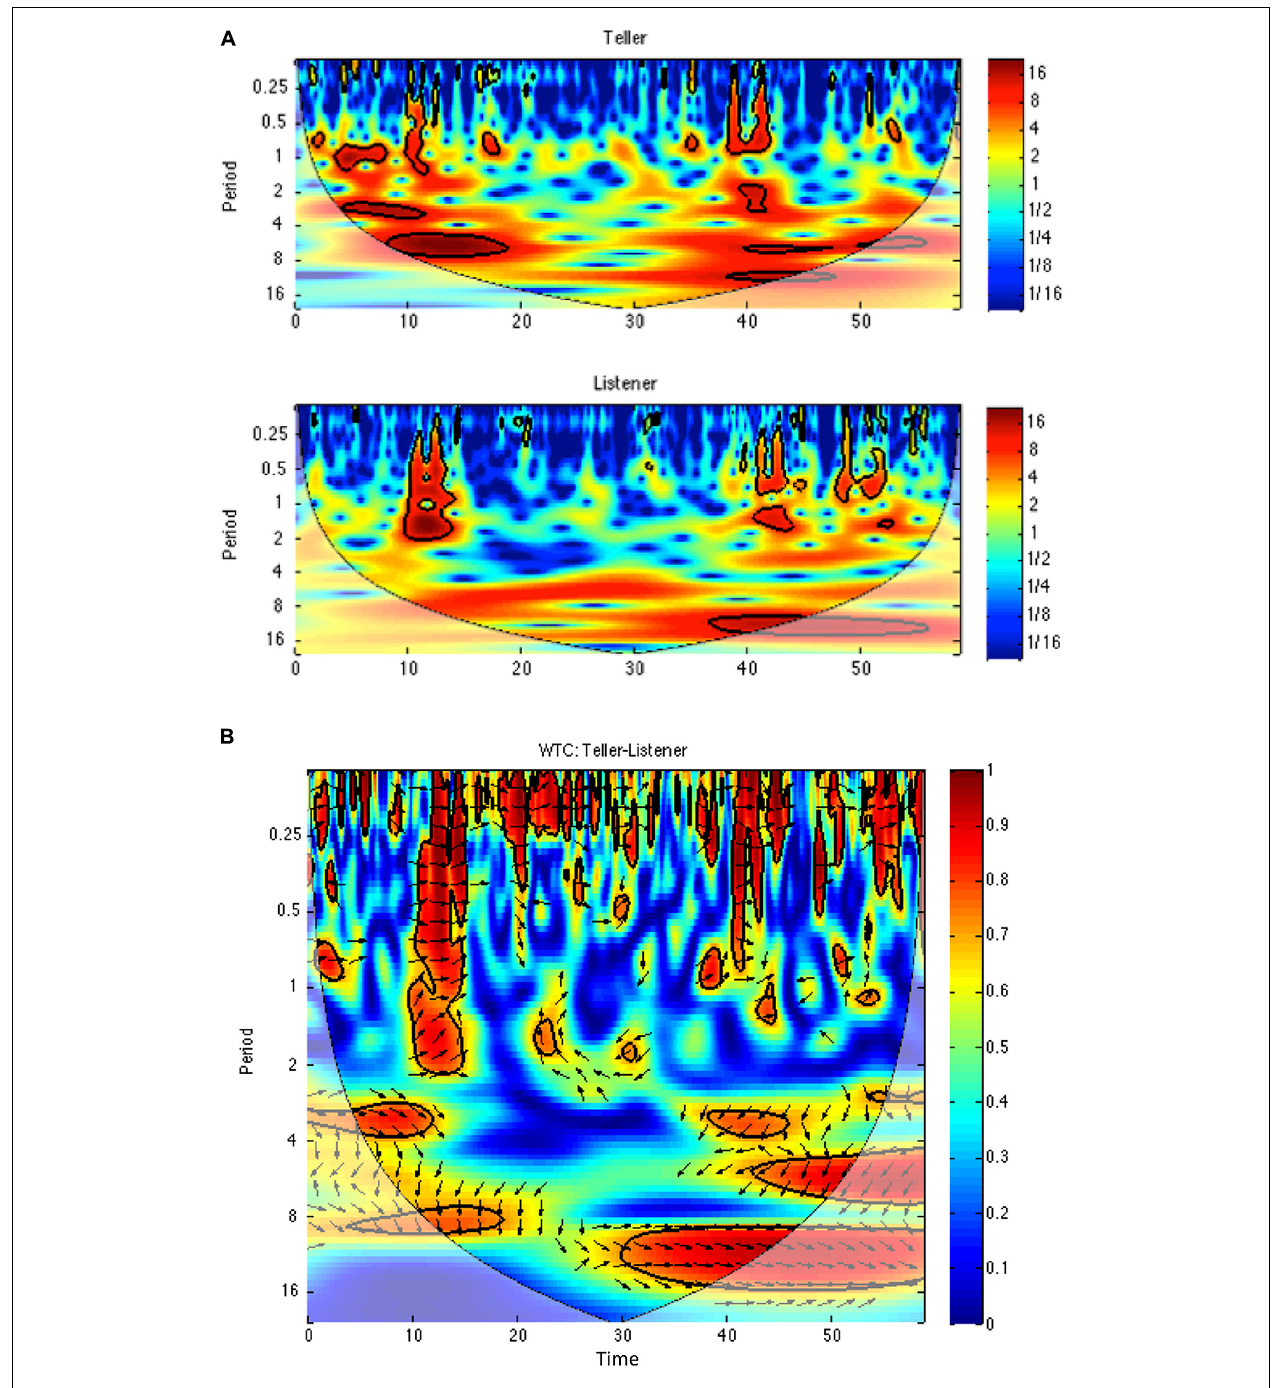
given time scale and a point in time are denoted by color and the orientation of the arrow (pointing right: teller–listener inphase; left: teller–listener antiphase; down: teller leading by 90 ◦ ), respectively. The average of these values at a given time scale were extracted from these plots to perform the time scale coherence and relative phase